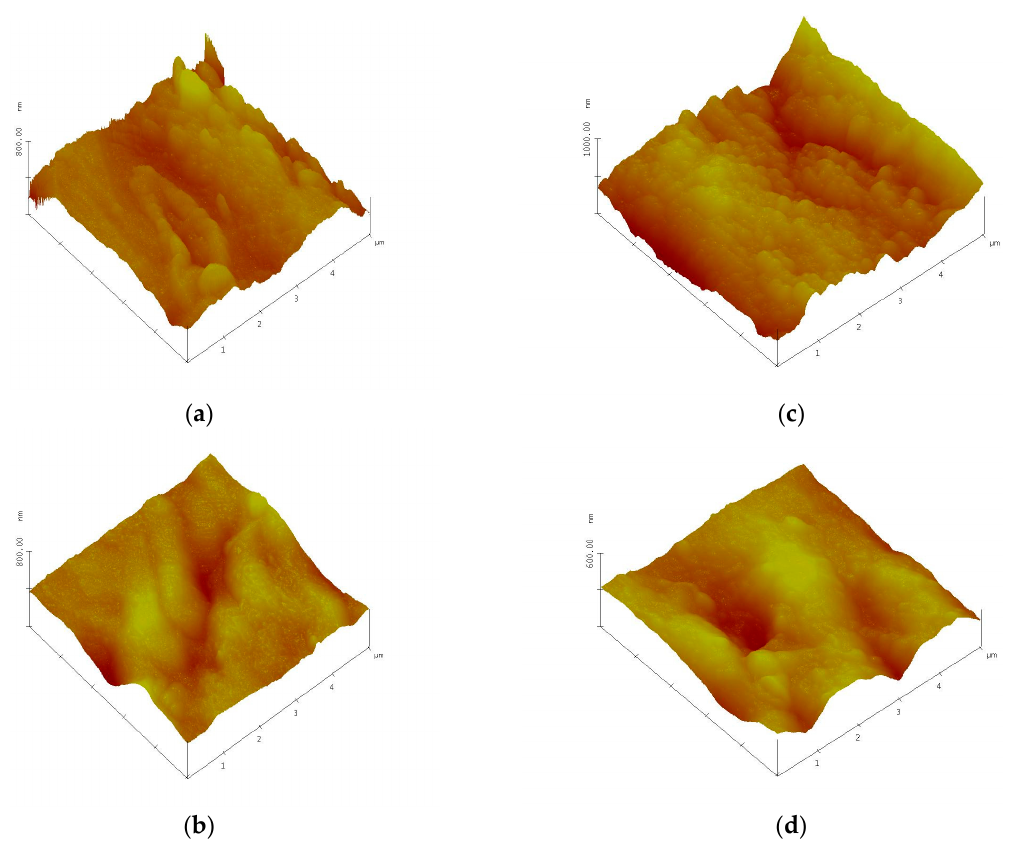
Figure 3. AFM 3D images of control wheat seeds ( a , b ) (‘Otilia’/’Dacic’) and plasma treated seeds ( c , d ) (‘Otilia’/’Dacic’); 5 × 5 µ m 2 scan